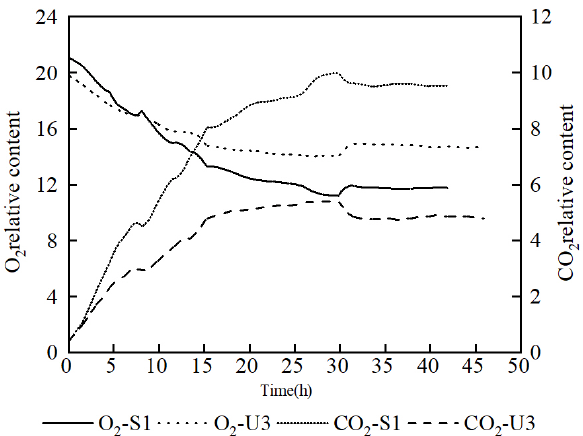
Figure 4. Comparison of o ff -gas analysis data between S1 and U3 on fed-batch fermentation.